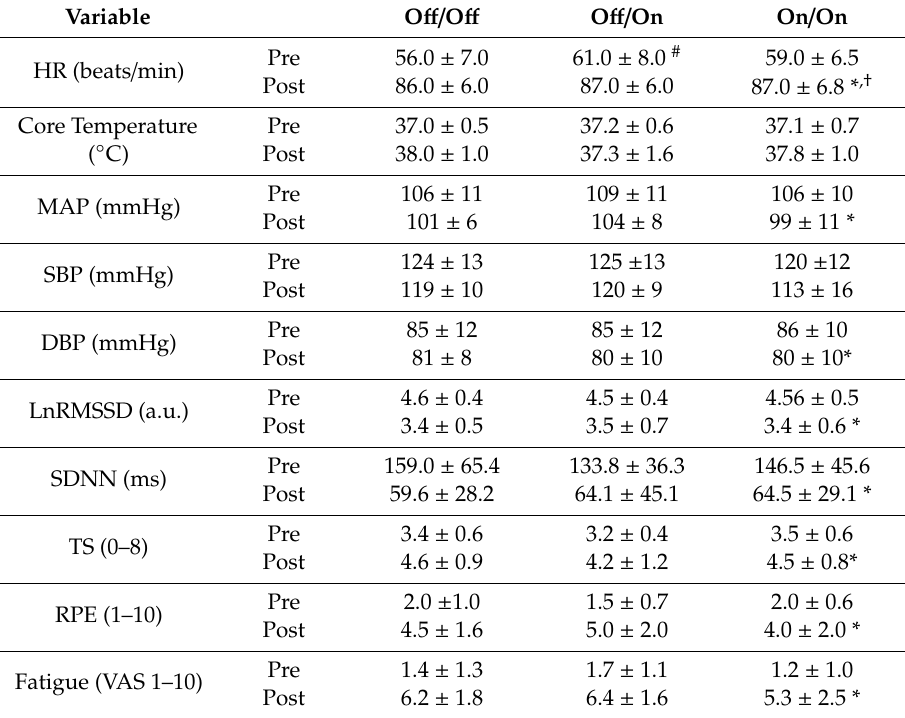
Table 2. Pre- and post-measurements for all three conditions ( n =